Question: Sum up the contents of this chart in one sentence.
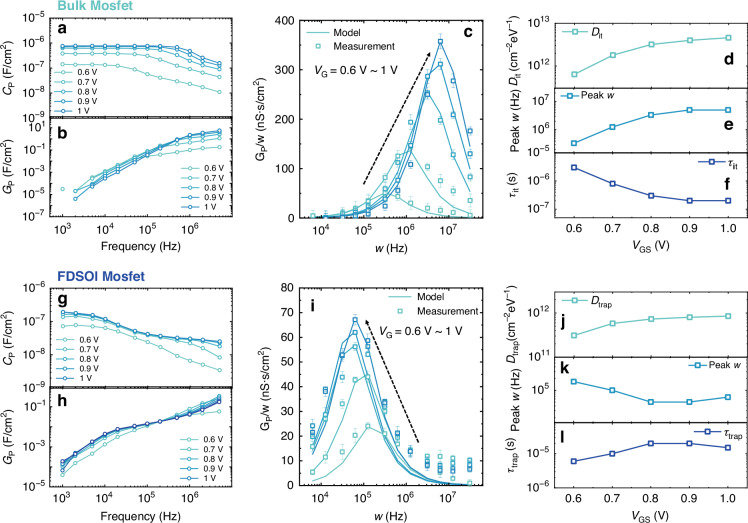
Answer: Frequency-dependent conductance and capacitance characteristics of bulk and FD-SOI MOSFETs measured using the conductance method. a , b Measured capacitance C p and conductance G p as a function of frequency for the bulk MOSFET at different V G s. c G p / ω spectra of the bulk MOSFET, measured from five devices sampled at representative locations across the 12-inch wafer, where the solid lines represent the measured data and the symbols denote the corresponding model fitting curves, showing a V G dependent shift in both the peak frequency and peak magnitude. d – f V G dependence of the extracted interface trap density D it , peak angular frequency, and trap time constant for the bulk MOSFET. g , h Measured C p and G p as a function of frequency for the FD-SOI MOSFET. i G p / ω spectra of the FD-SOI MOSFET, collected from five devices distributed across representative regions of the 12-inch wafer, exhibiting a weak dependence of the peak frequency on V G . j – l Gate-voltage dependence of the extracted trap density, peak angular frequency, and effective trap time constant for the FD-SOI MOSFET